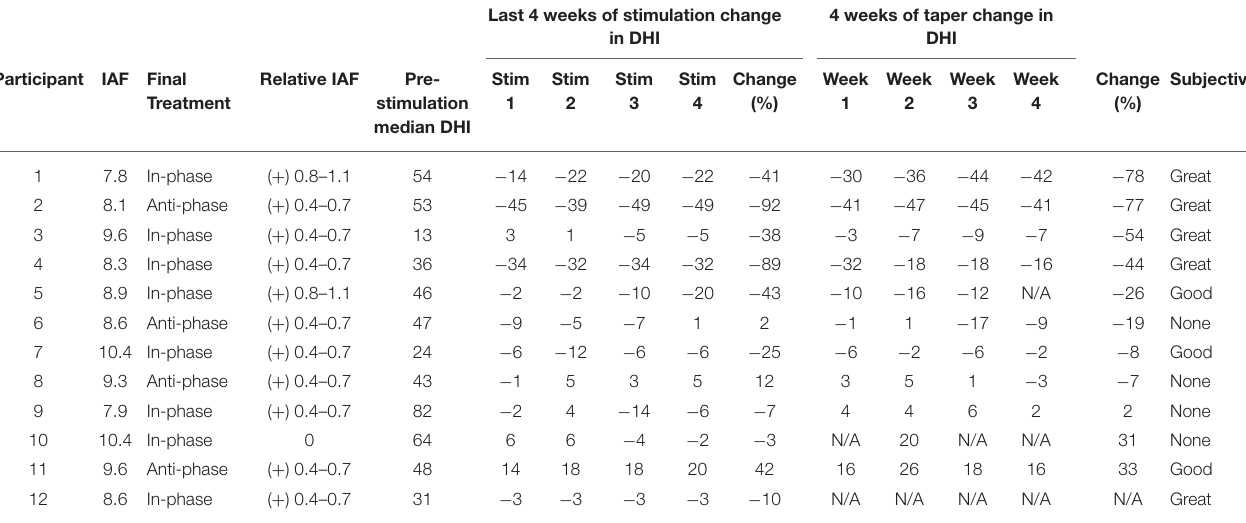
Last 4 weeks of stimulation change in DHI